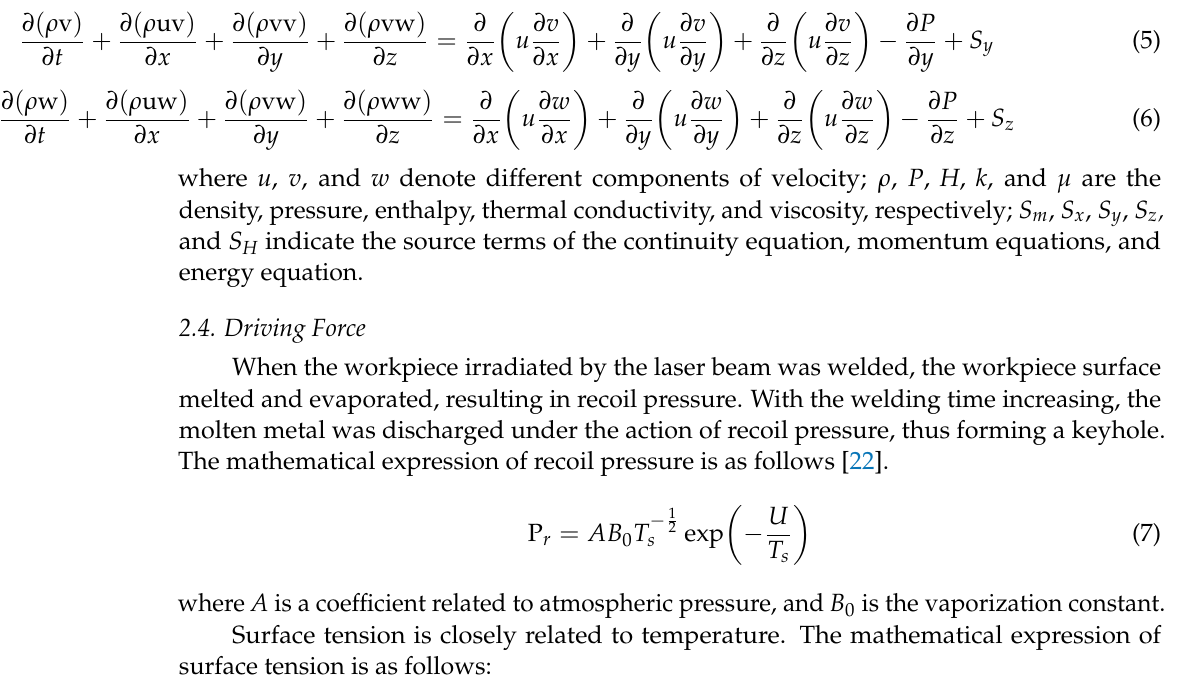
Table 1. Physical and thermal properties of the 6056 aluminum alloy. Property Symbol Unite Value Solid density ρ s Liquid density Solidus temperature